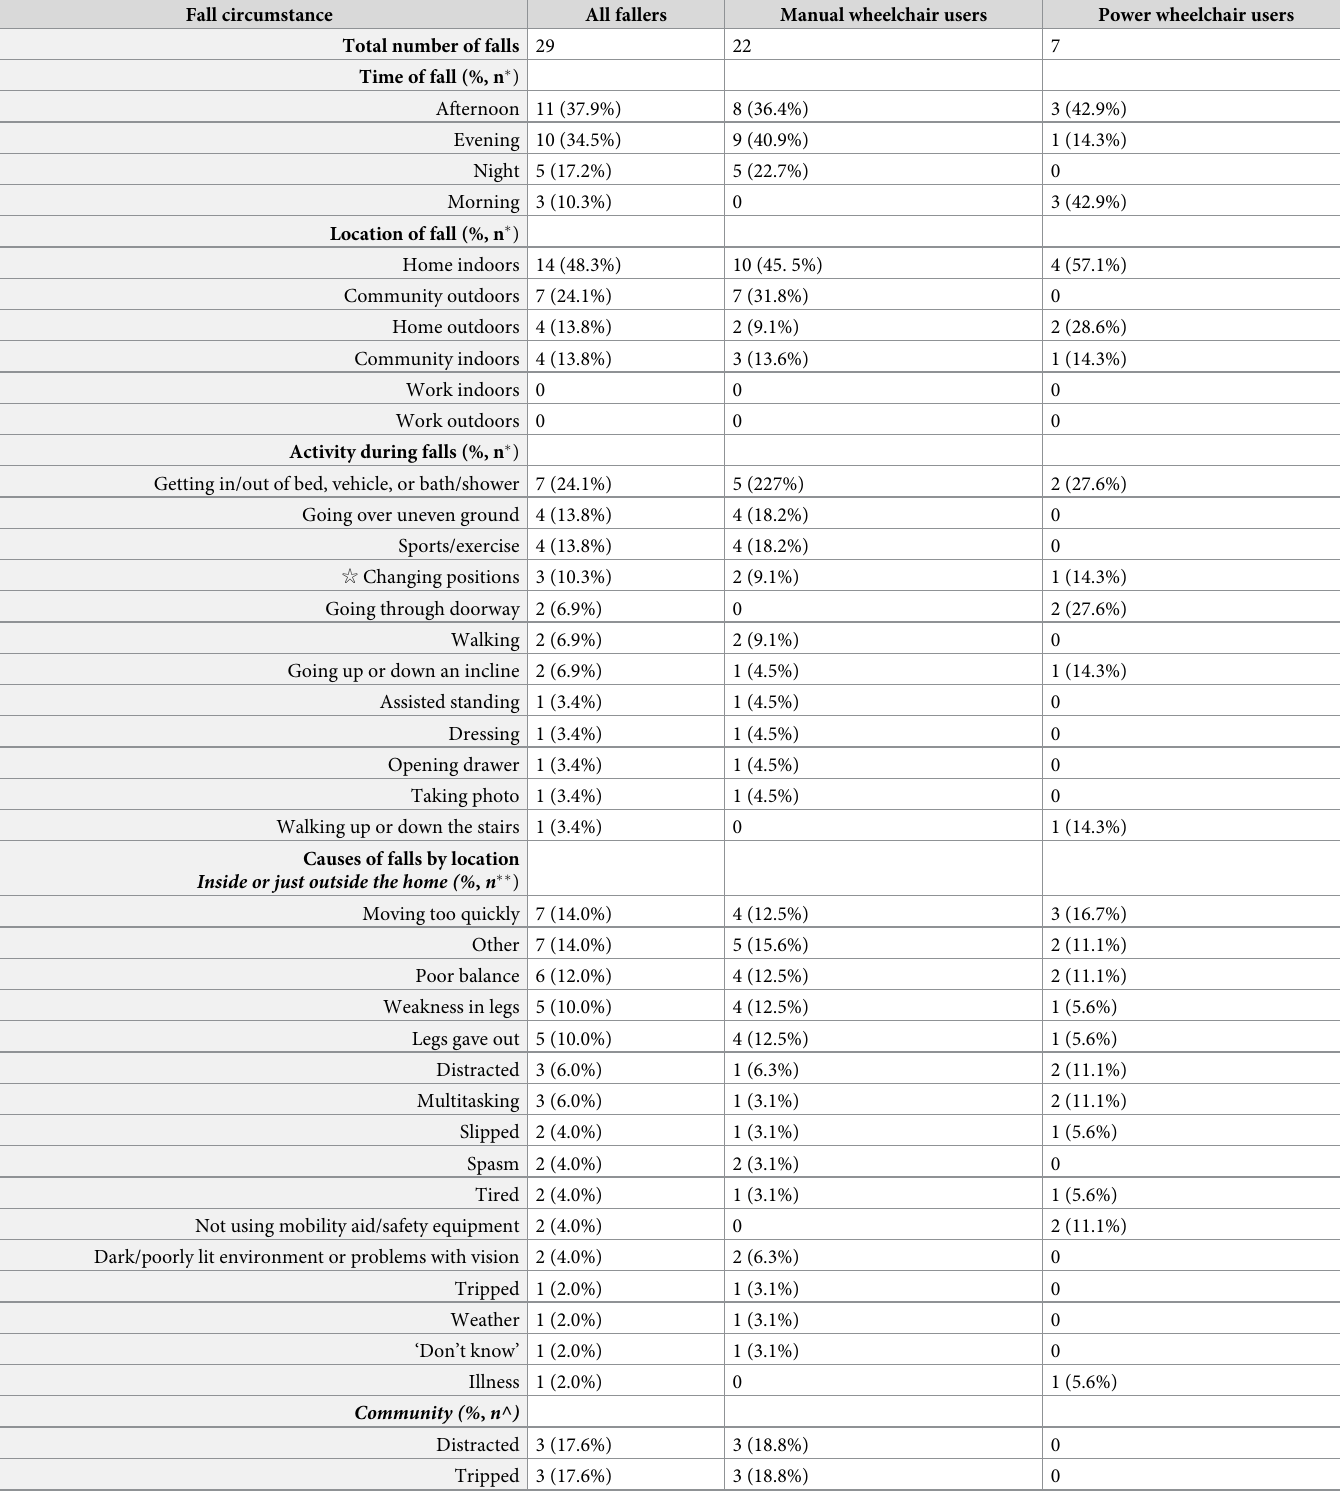
Table 2. Fall circumstance for entire group, power wheelchair users and manual wheelchair